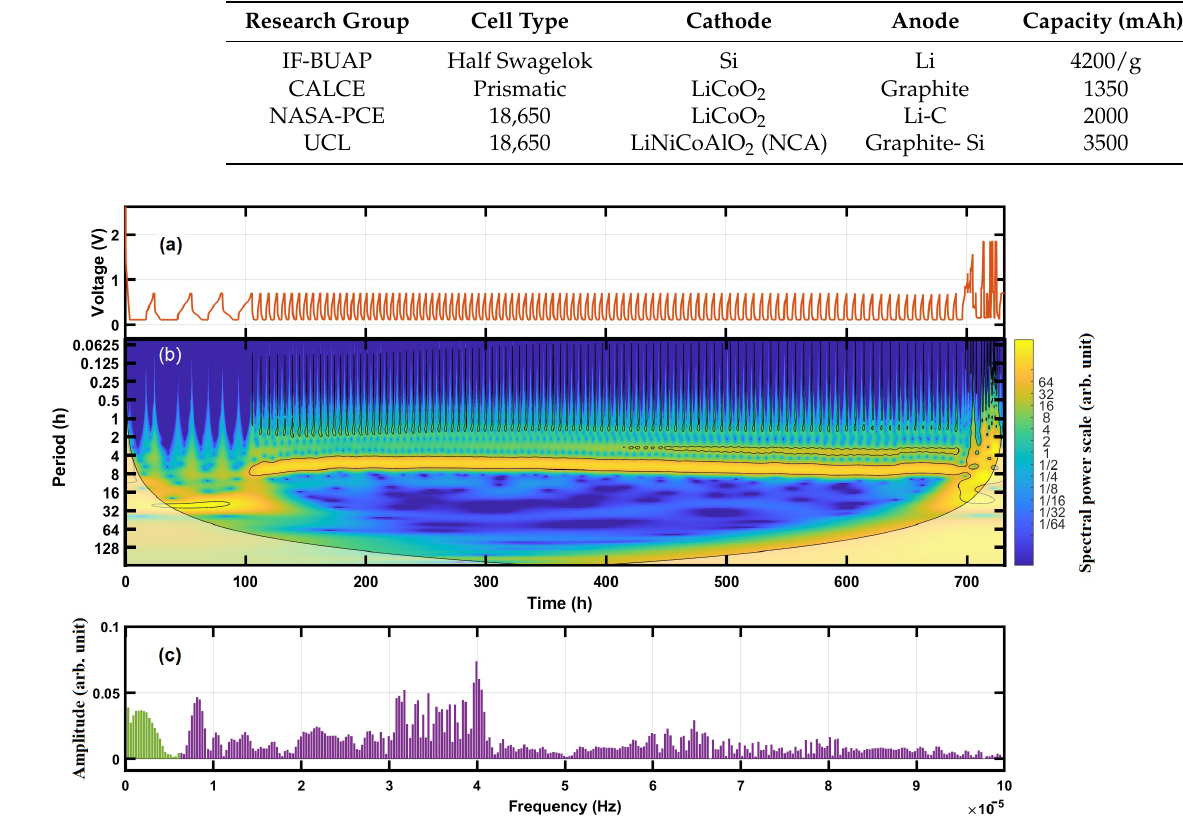
Figure 3. ( a ) Voltage, ( b ) wavelet spectral power ( b ), and ( c ) Fourier spectrum of the cycling test performed to HC3 cell by IF-BUAP. The frequencies in green indicate the frequencies preceding the failure, while those in purple indicate the frequencies late to the